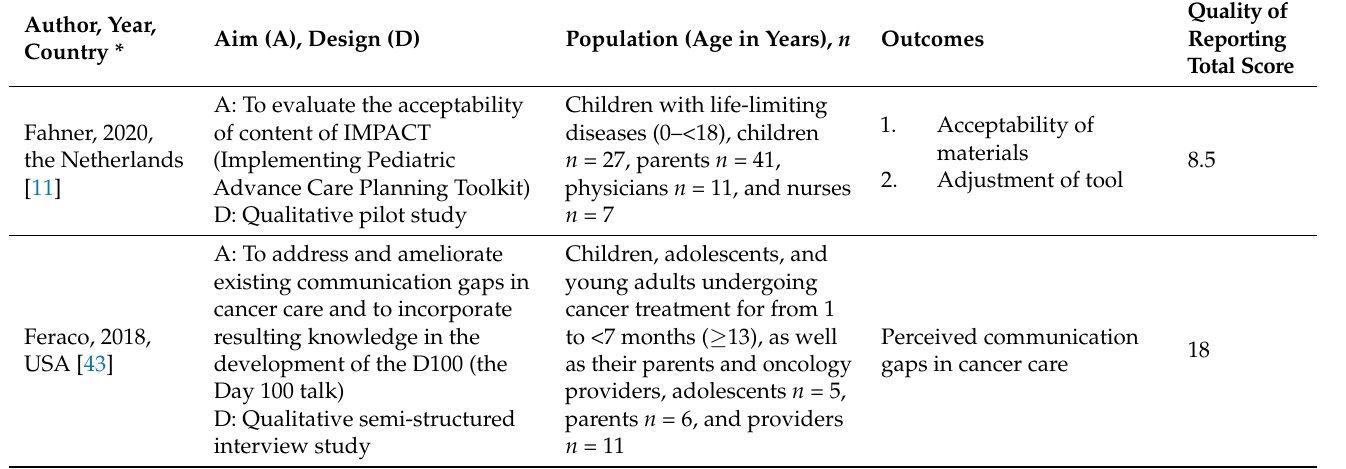
Table 5. Evidence from qualitative